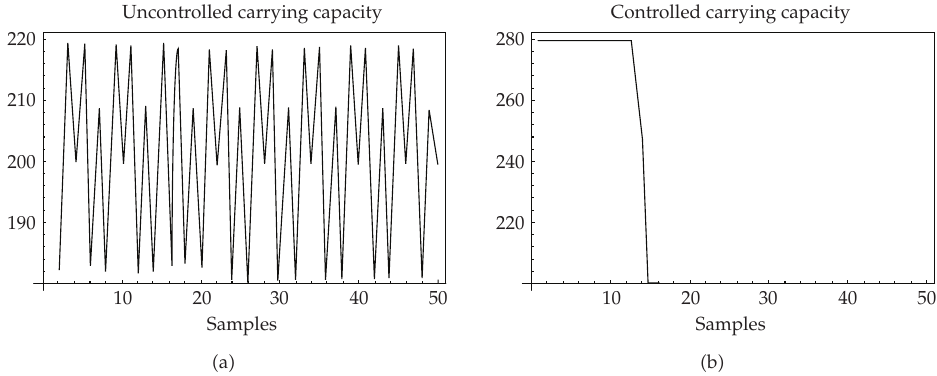
Figure 4: Environment carrying capacities: (cid:2) a (cid:3) uncontrolled BHE and (cid:2) b (cid:3)